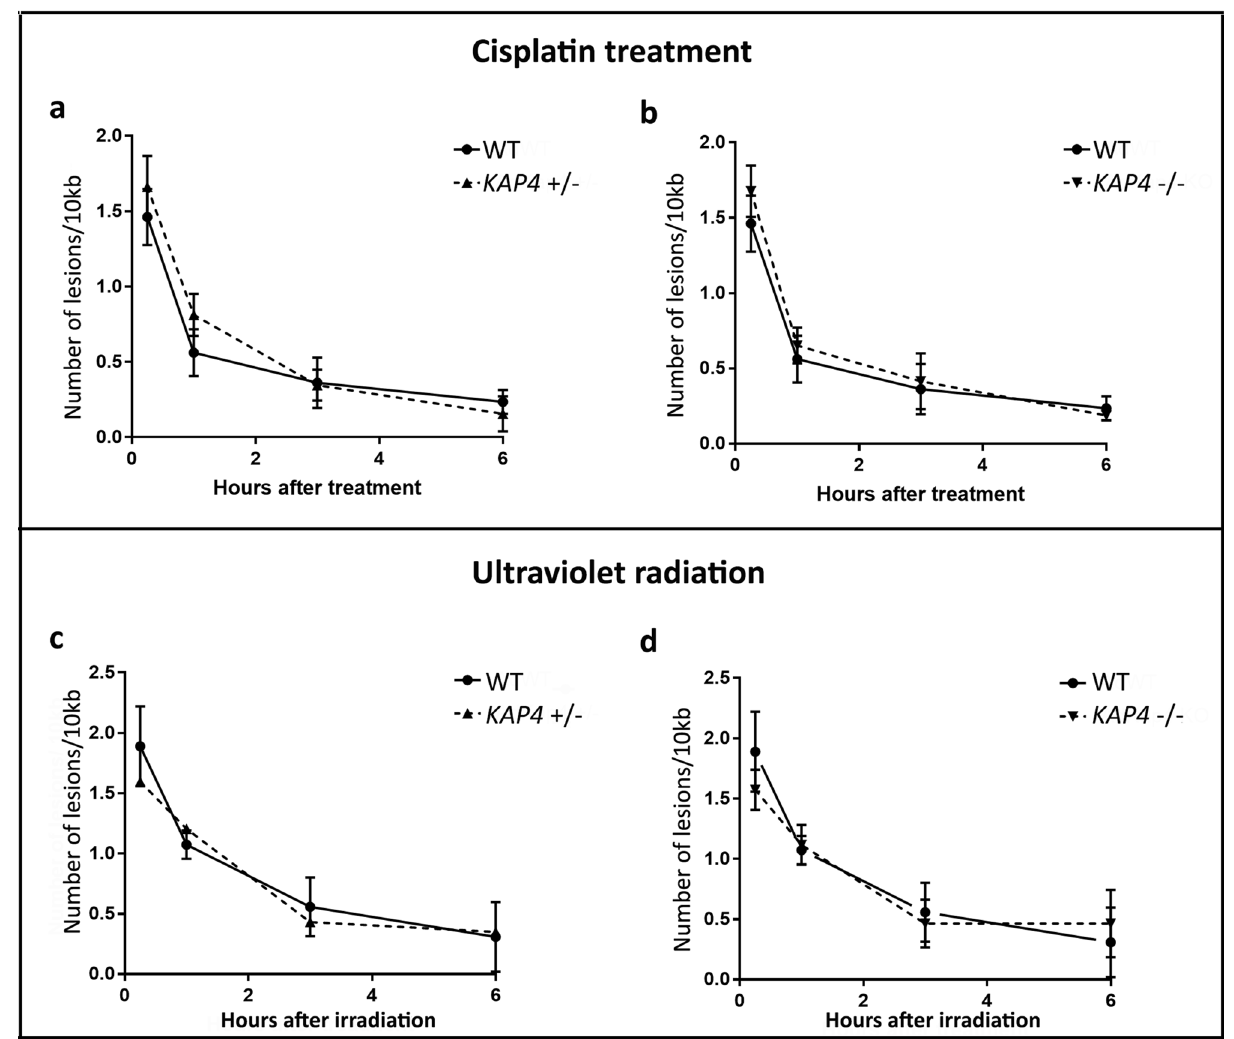
Figure 9. DNA repair kinetics of WT and mutant cells. ( a , b ) DNA repair kinetics of WT cells compared to kap4 +/− cells (left panel) and kap4 −/− (right panel) after treatment with 300 µM cisplatin. ( c , d ) DNA repair kinetics of WT cells in relation to kap4 +/− cells (left panel) and kap4 −/− (right panel) after UV damage radiation. As observed for cisplatin, no significant difference was observed in the DNA repair kinetics of all cell